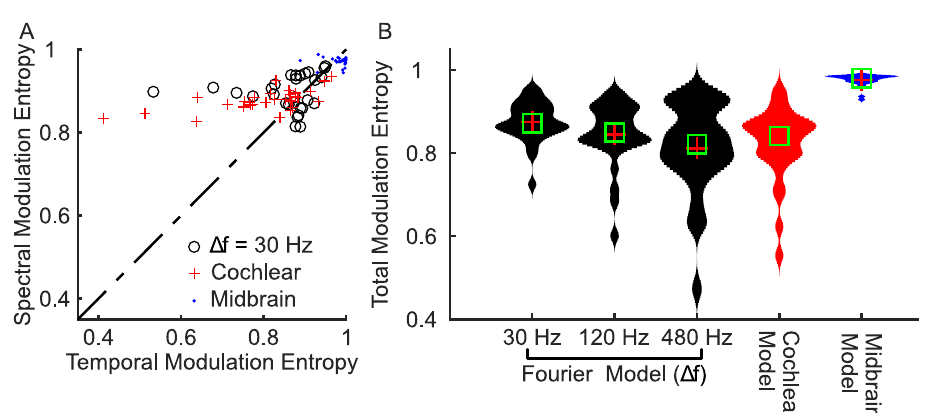
Fig 8. Midbrain model decomposition maximizes the modulation entropy of natural sounds. (A) Spectral and temporal modulation entropy are significantly higher for the midbrain model when compared against Fourier (black; Δ f = 30 Hz) and cochlear model (red). (B) The total modulation entropy is highest for the midbrain model when compared against Fourier and cochlear